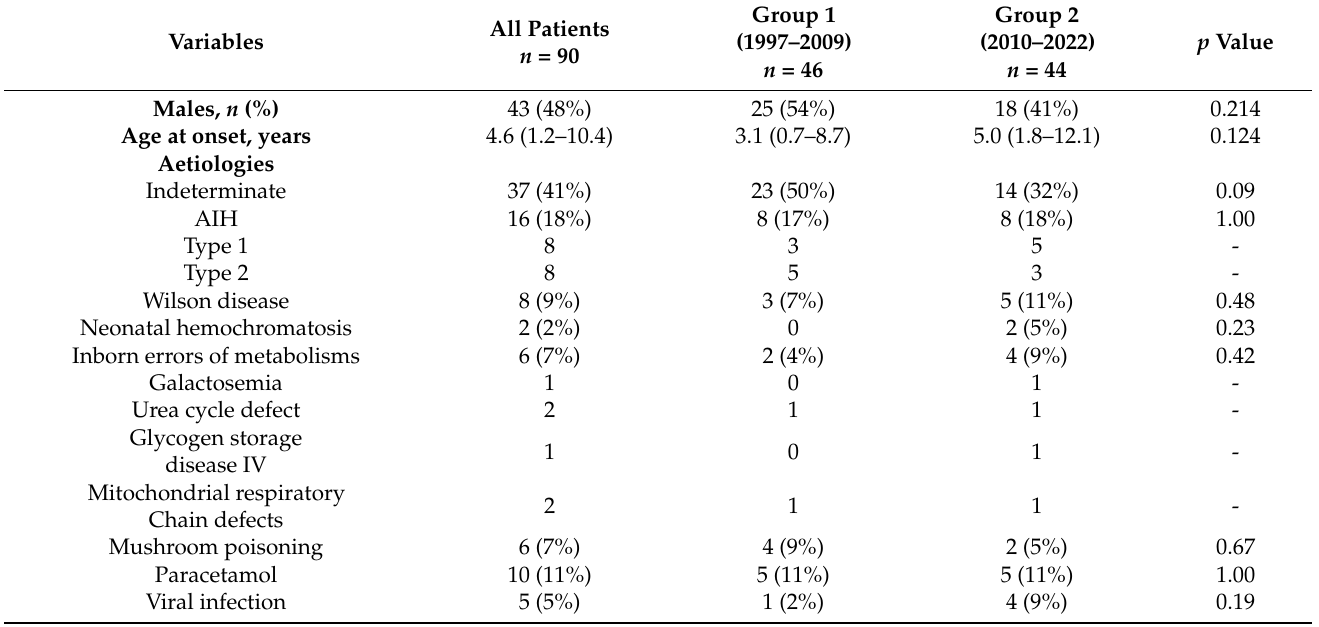
Table 1. Characteristics at baseline in 90 children with ALF divided into two